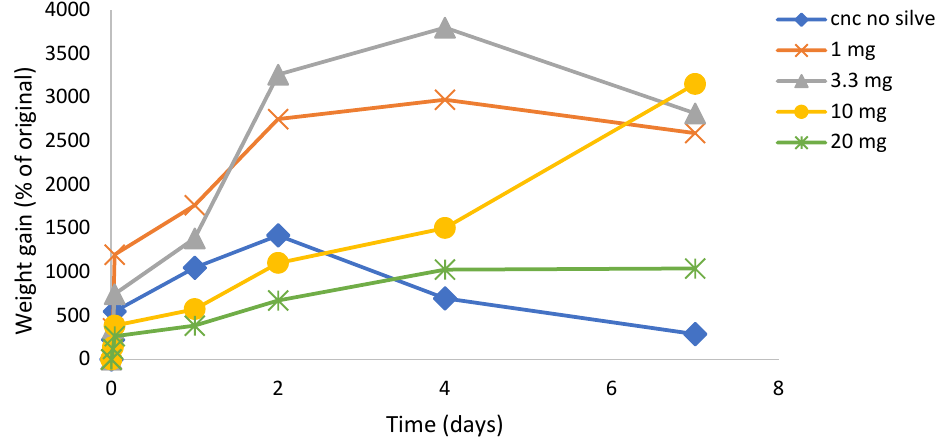
Figure 6. Time course of swelling of silver nitrate loaded CNC hydrogel films in water using various loadings of silver nitrate. Loadings describe weight of silver in 500 mg manufactured films, thus 10 mg is equivalent to 2% silver loading.